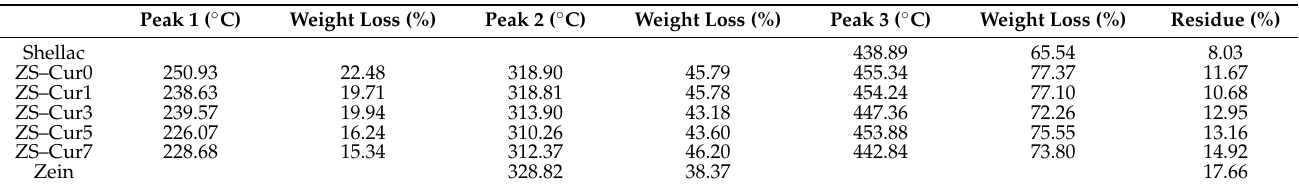
Table 4. Weight loss of shellac, zein, and composite films at distinct stages by TGA.